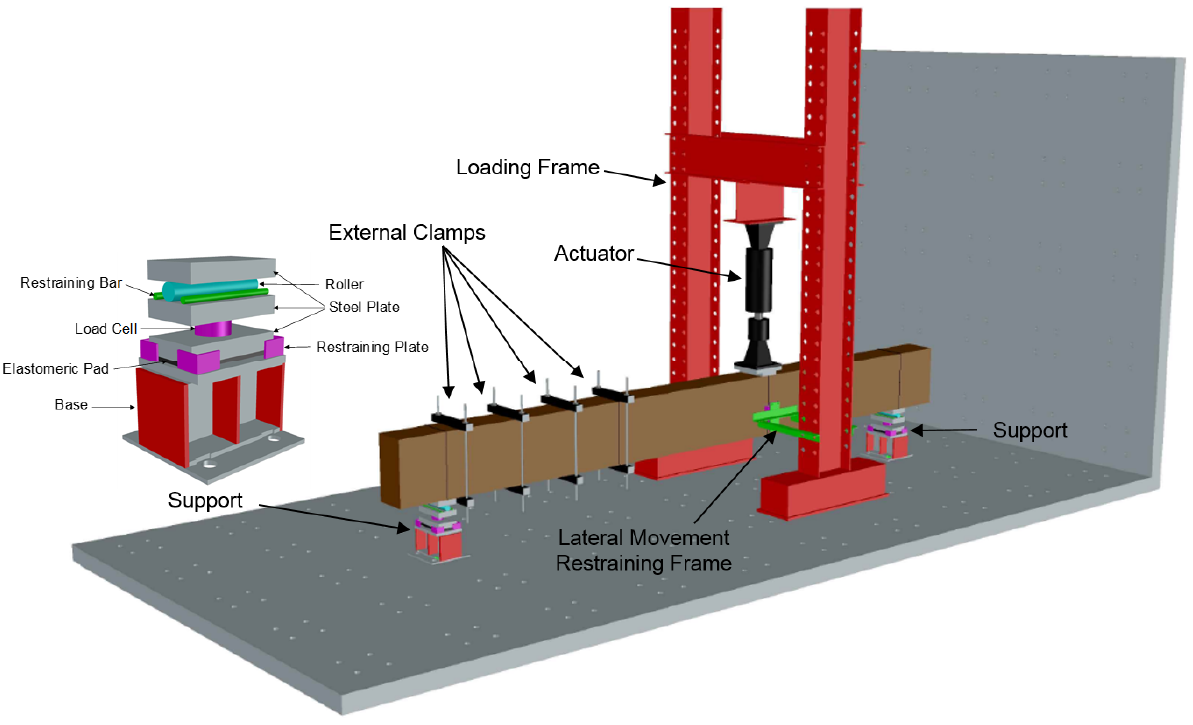
Figure 5. Test setup.